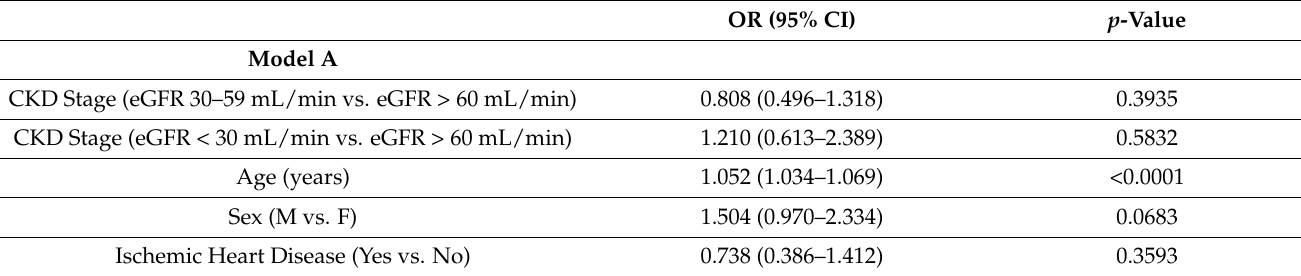
Table A4. Logistic model on the impact of CKD on incident AF adjusted by age, sex, comorbidities and laboratory measurements (Model A), by sex (Model B) and by sex, comorbidities, and laboratory measurements (Model C) n = 2386, AF = 112. OR (95% CI) p